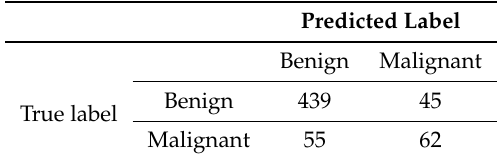
Table 7. Confusion matrix—TF + Jigsaw with data augmentation.